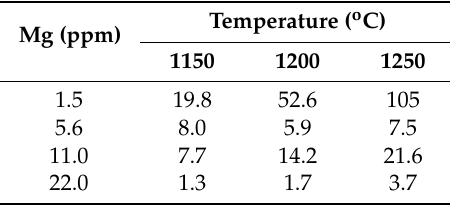
Figure 9. The grain boundary velocity ( V ) as a function of net driving force ( F P − F R ) for ( a ) 1.5 ppm, ( b ) 5.6 ppm, ( c ) 11 ppm and ( d ) 22 ppm Mg, where F P is the driving force of grain growth, and F R the retarding force on boundaries. Table 6. The values of mobility [10 − 4 × m 4 /(kJ · s)] for 1.5–22 ppm Mg at temperatures of 1150, 1200 and 1250 °C.